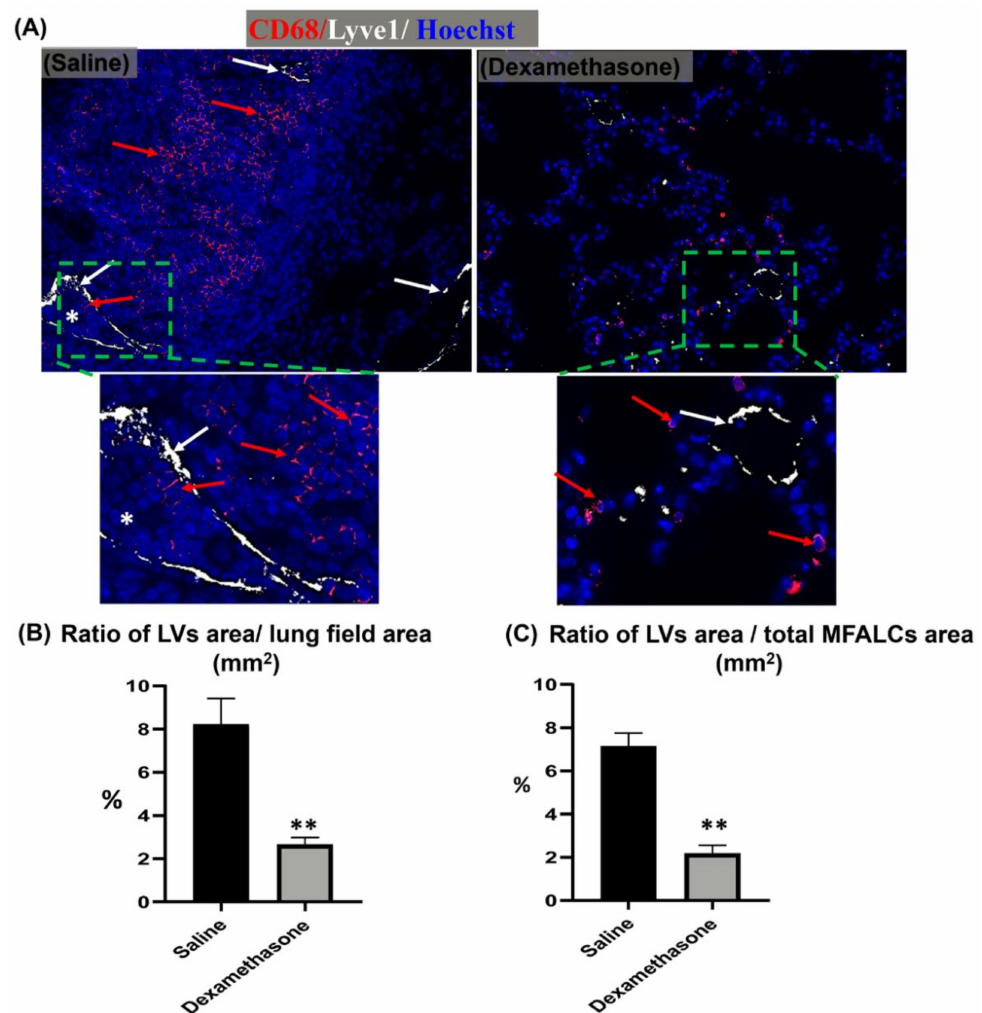
Figure 5. Analysis of the effect of dexamethasone on the degree of the development of lymphatic vessels (LVs) in the lungs and mediastinal fat associated-lymphoid clusters (MFALCs) in female Lpr mice. ( A ) Representative images of the dual immunofluorescent stained lung section with anti- CD68 + macrophages (red) and anti- LYVE-1 (white) antibodies. Notice CD68 + macrophages (red arrows), LYVE-1 + LVs (white arrows), and engorged LVs with immune cells (*). ( B , C ) Representative graphs showing the percentages of LYVE-1 + LV relative area ratios in the immunohistochemical-stained lungs ( B ) and MFALCs ( C ) tissue sections. Highly significant values (**) were observed between the saline and dexamethasone groups ( p values < 0.01), where n = 5 in each experimental group. Analysis was conducted using the Mann–Whitney U test. Data are presented as mean values ±